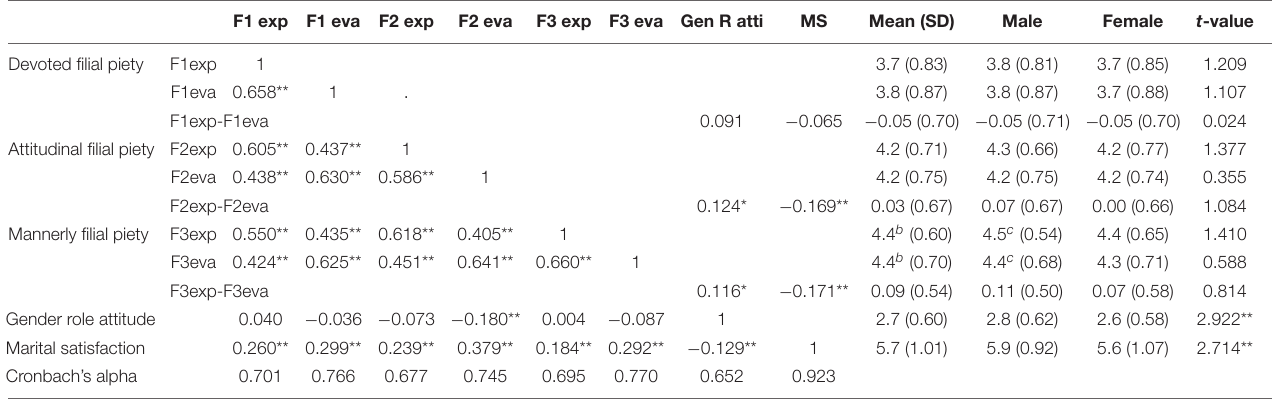
TABLE 2 | Descriptive statistics, correlations, and independent t -test between gender results of different variables a